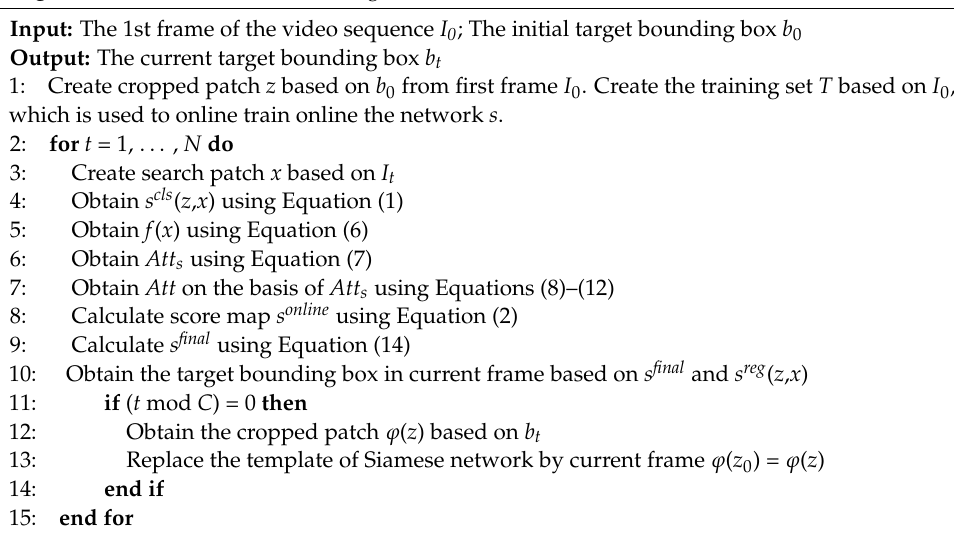
Algorithm 1 Flow of Online Tracking